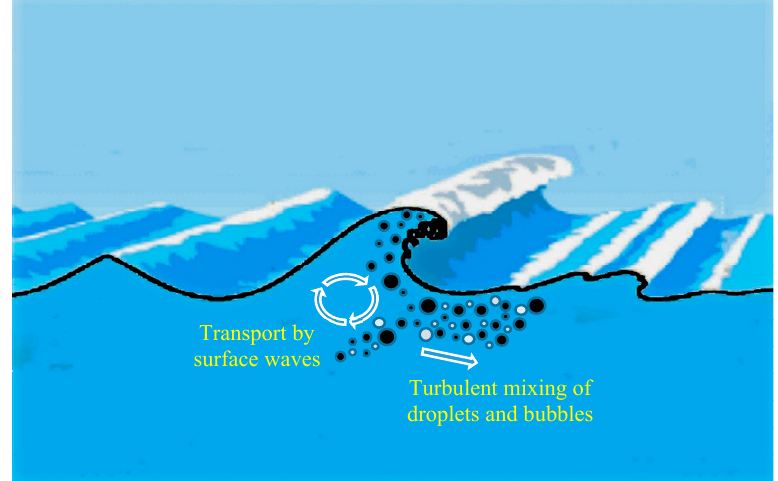
Figure 1. Schematic illustration of oil dispersion due to breaking waves at the ocean surface. The black disks represent oil droplets, while white disks denote air bubbles.